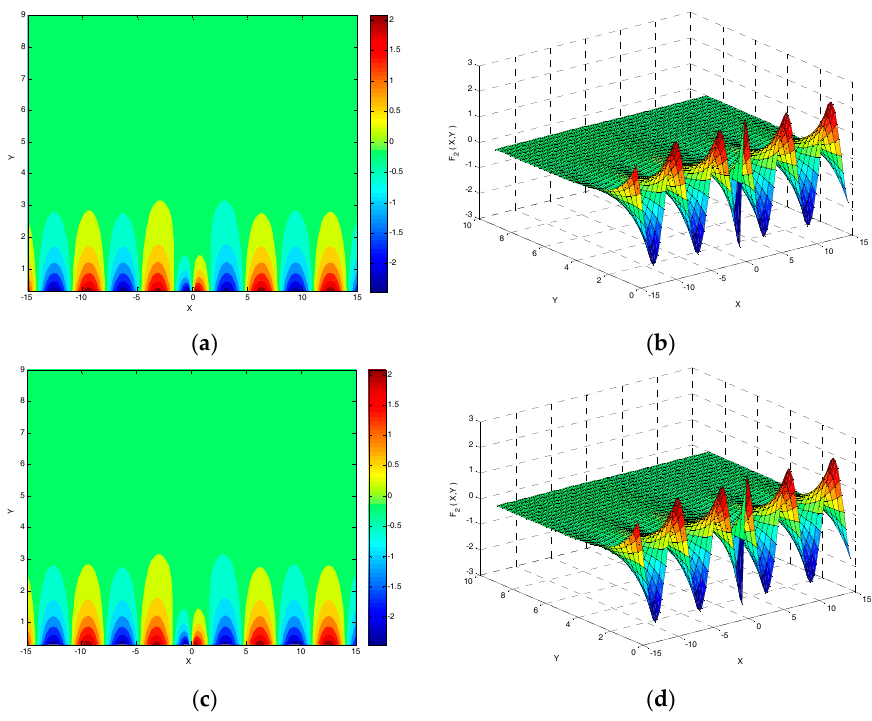
Figure 3. Comparison of the singular function F 2 ( X , Y ) calculated by the two methods. For captions of the subplots please refer to Figure 2. Computation 2016 , 4 , 36